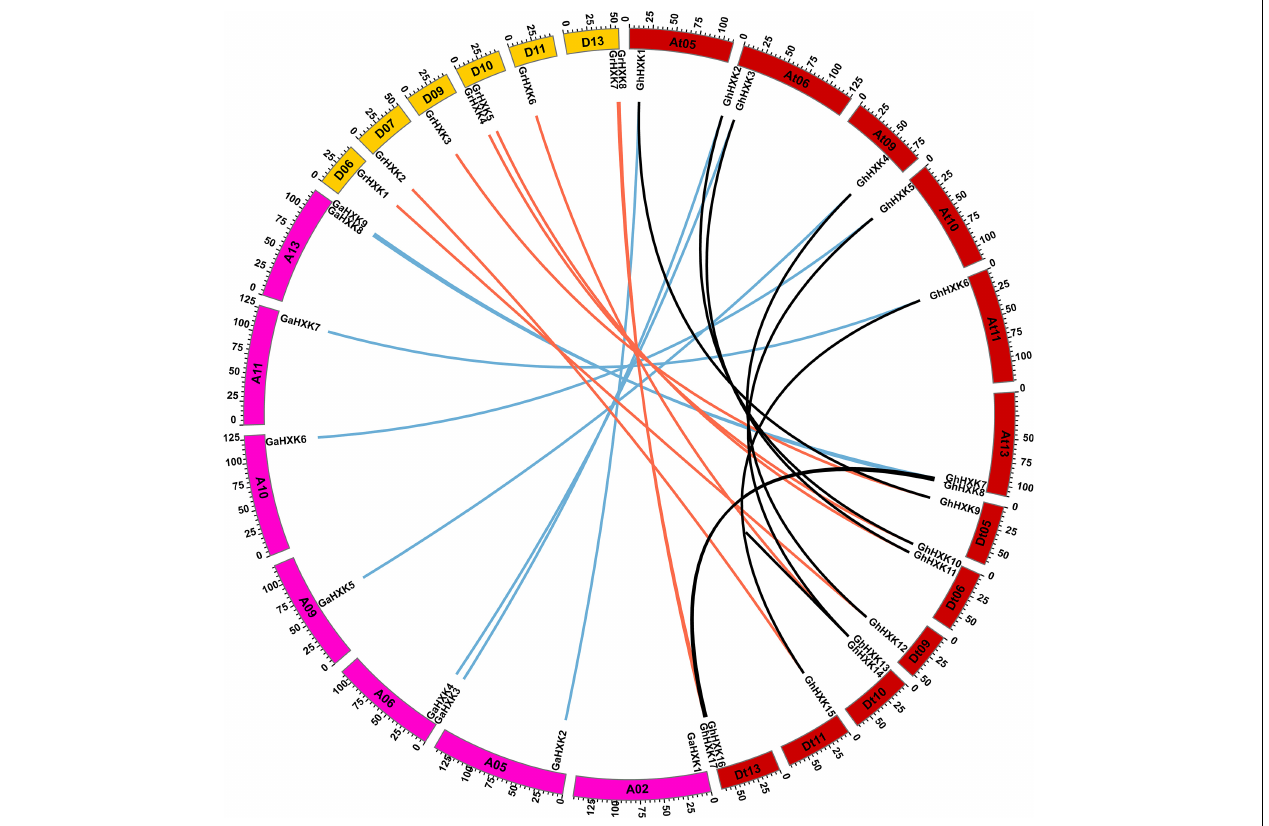
FIGURE 6 | Circos plot showing GhHXKs paralogous gene pairs and orthologous gene pairs. Black lines connect the paralogous GhHXKs gene pairs. Red lines connect the paralogous gene pairs between GhHXKs and GrHXKs . Blue lines connect the paralogous gene pairs between GhHXKs and GaHXKs